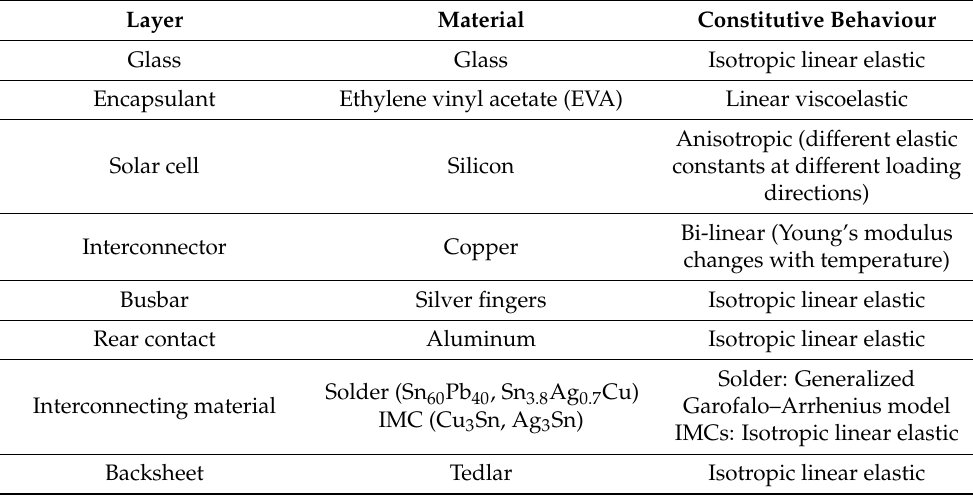
Table 2. Solar cell material constitutive model.